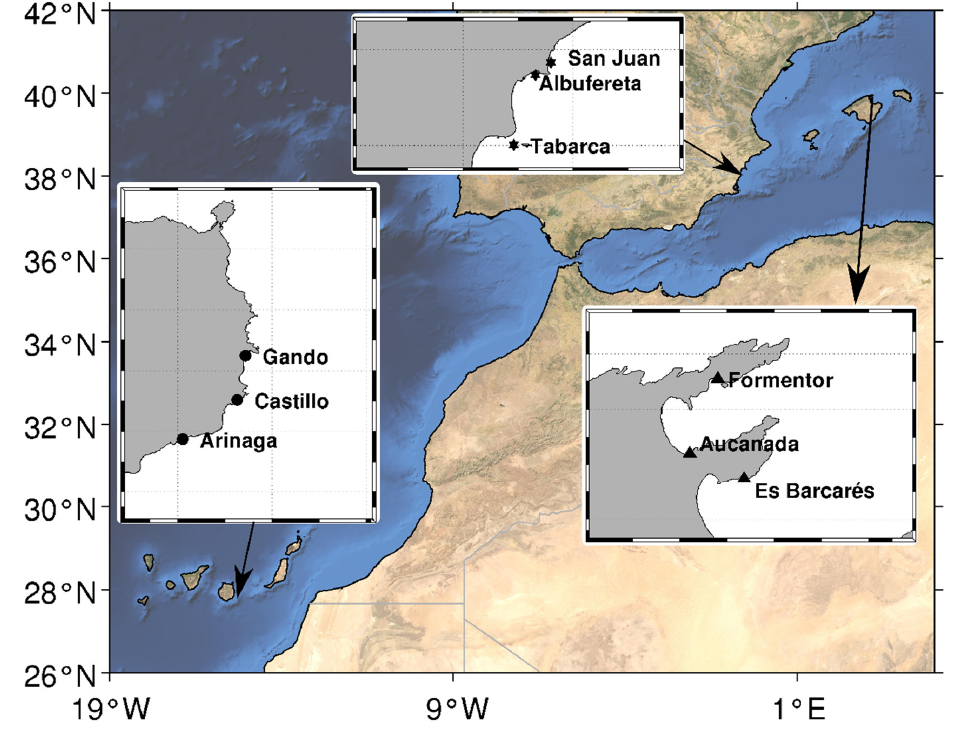
Figure 1 . Study area detailing the location of the three Cymodocea nodosa meadows sampled in each region, including the Atlantic region (black ellipses, Gran Canaria) and the Mediterranean regions (black stars, Alicante and black triangles, Mallorca).